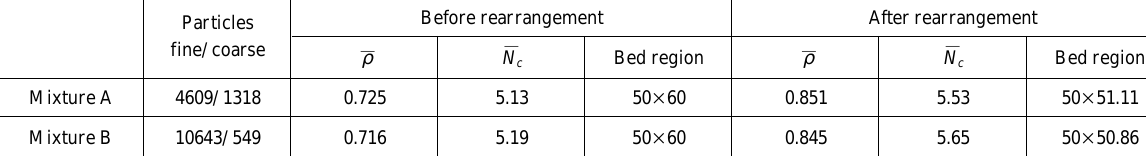
Table 2 Average density, coordinate number and particle bed region before and after particle rearrangement.